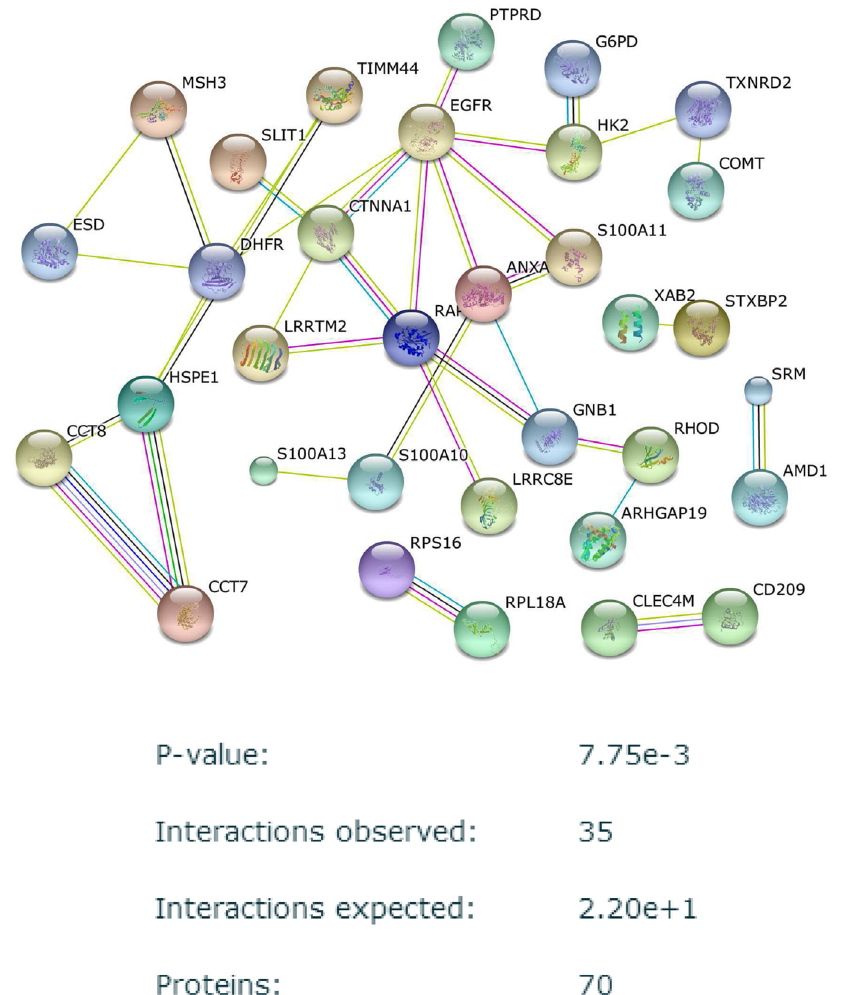
Fig 9. Protein-protein interaction network observed between top regulators found from CMRF in GDSC dataset S C 1 . Disconnected nodes are